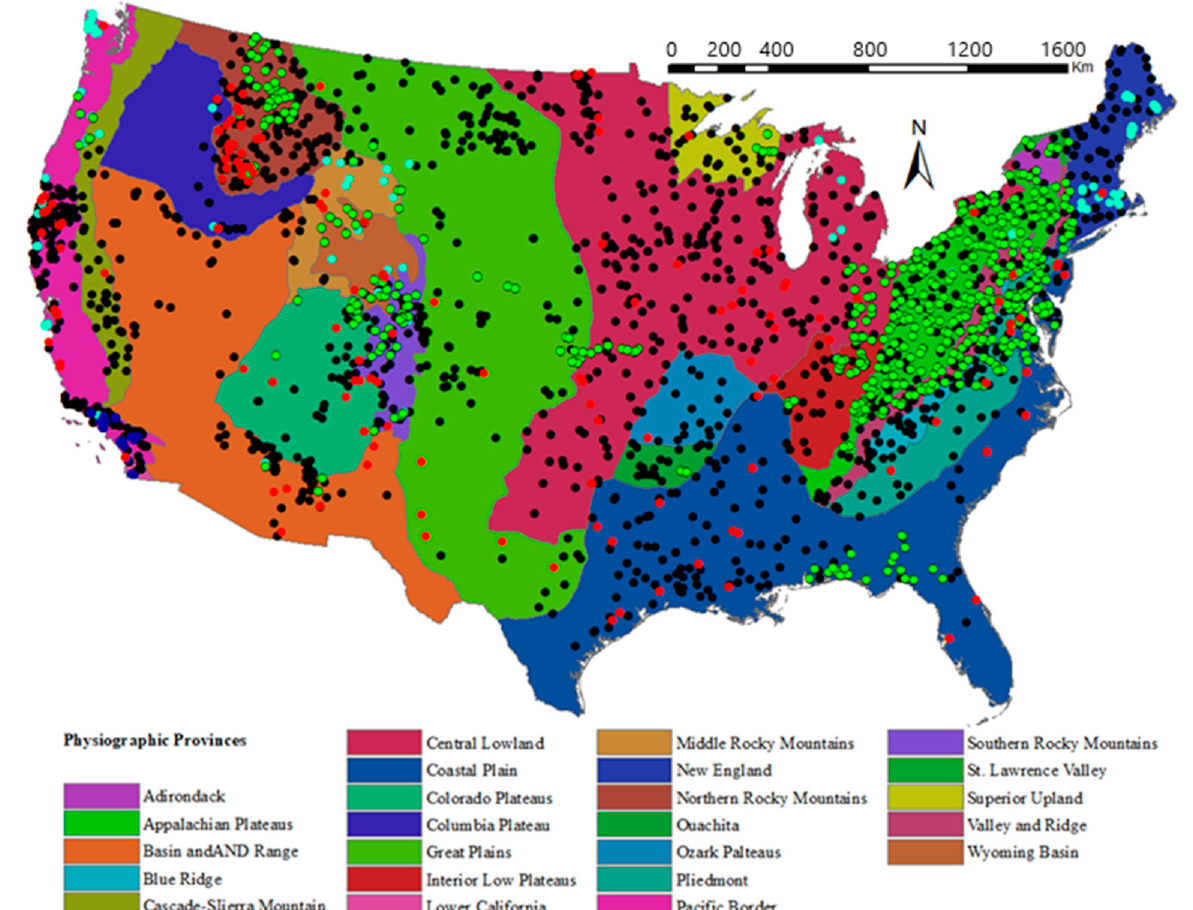
Figure 6. Distribution of D50 data points over Physiographic Provinces.